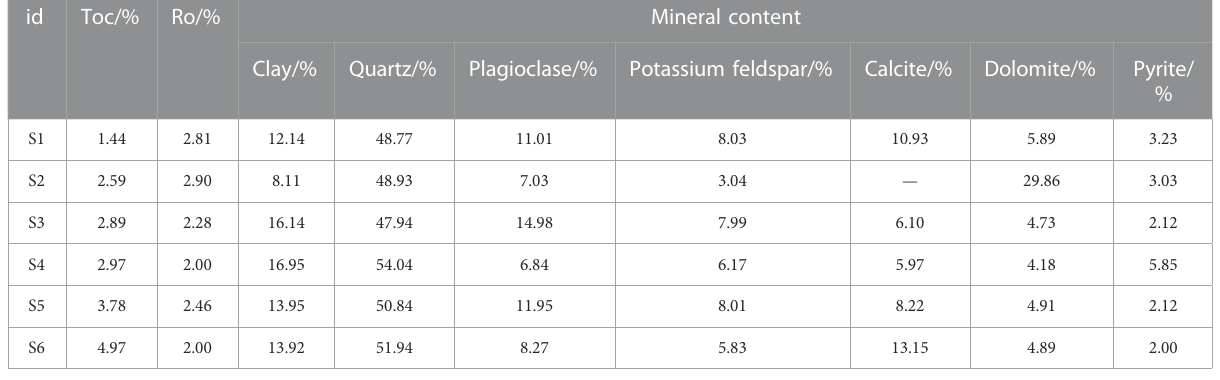
TABLE 1 Detailed basic physical properties of the selected shales.